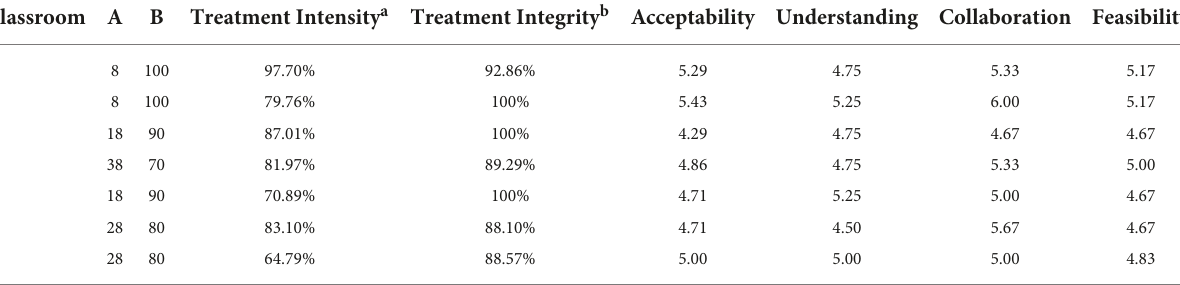
TABLE 2 Design data, treatment integrity, and treatment usability for each